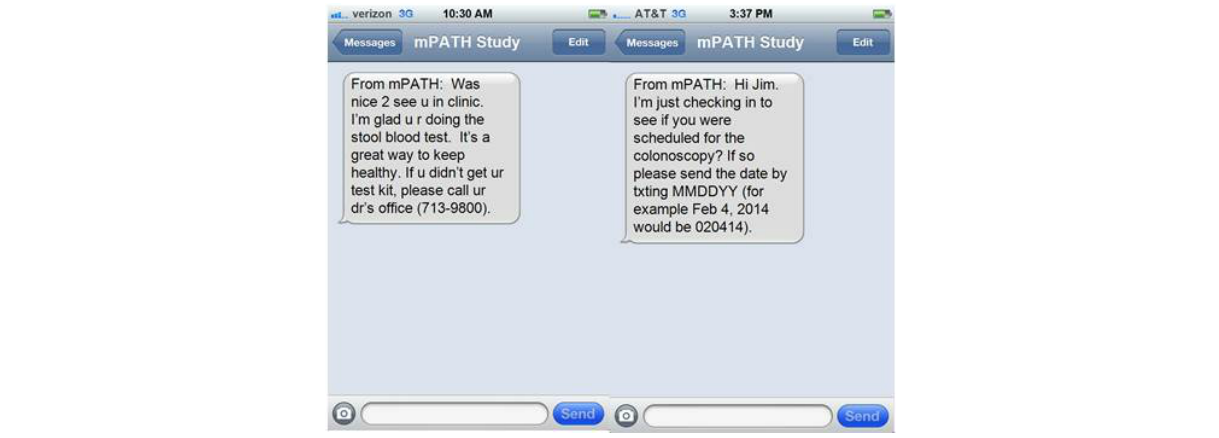
Figure 1. Examples of text messages that participants viewed regarding colon cancer screening.